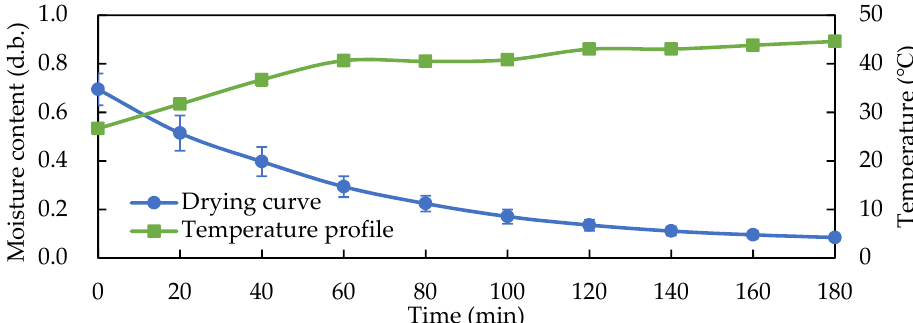
Figure 10. Temperature profile and drying curve during 45 °C hot-air drying of the solid-state fermented W. cocos products. Data are expressed as the mean ± SD ( n = 3).